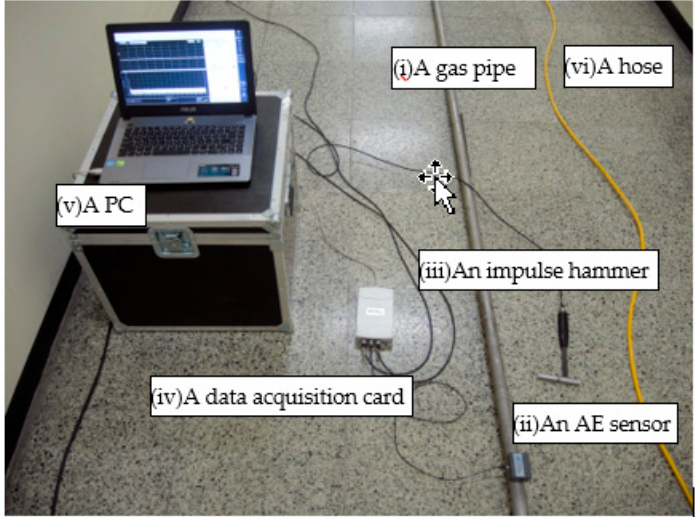
Figure 5. Experiment system diagram: (i) a gas pipe, (ii) two AE sensors, (iii) an impulse hammer, (iv) a data acquisition card, (v) a PC, and (vi) a hose.